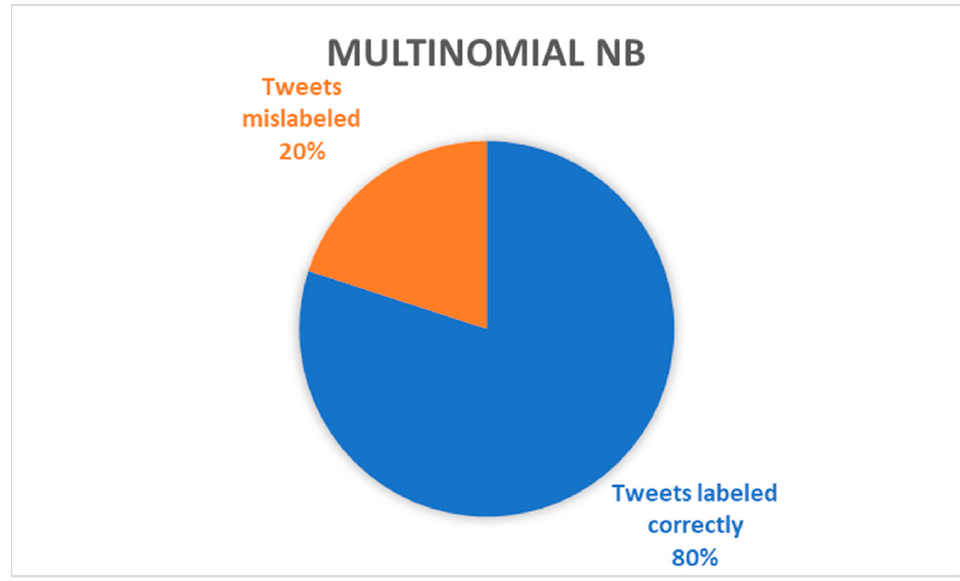
Figure 7. Graphical representation of the accuracy of the Multinomial NB